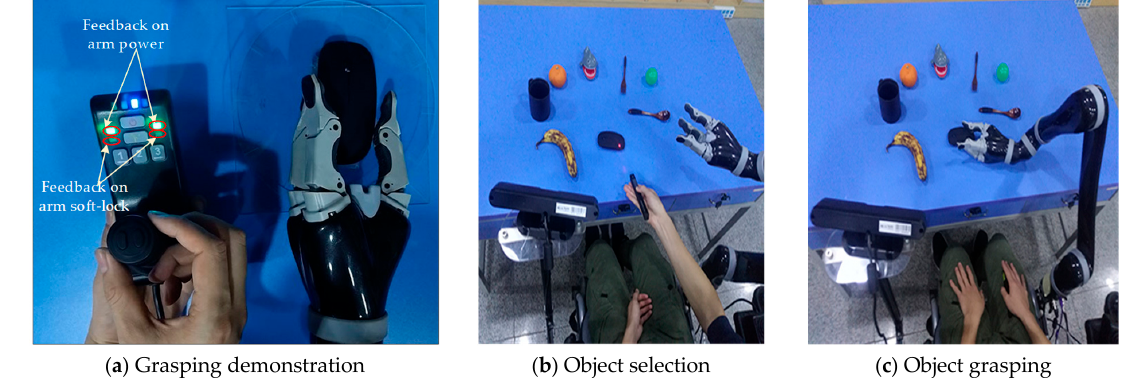
Figure 15. Process of object grasping.